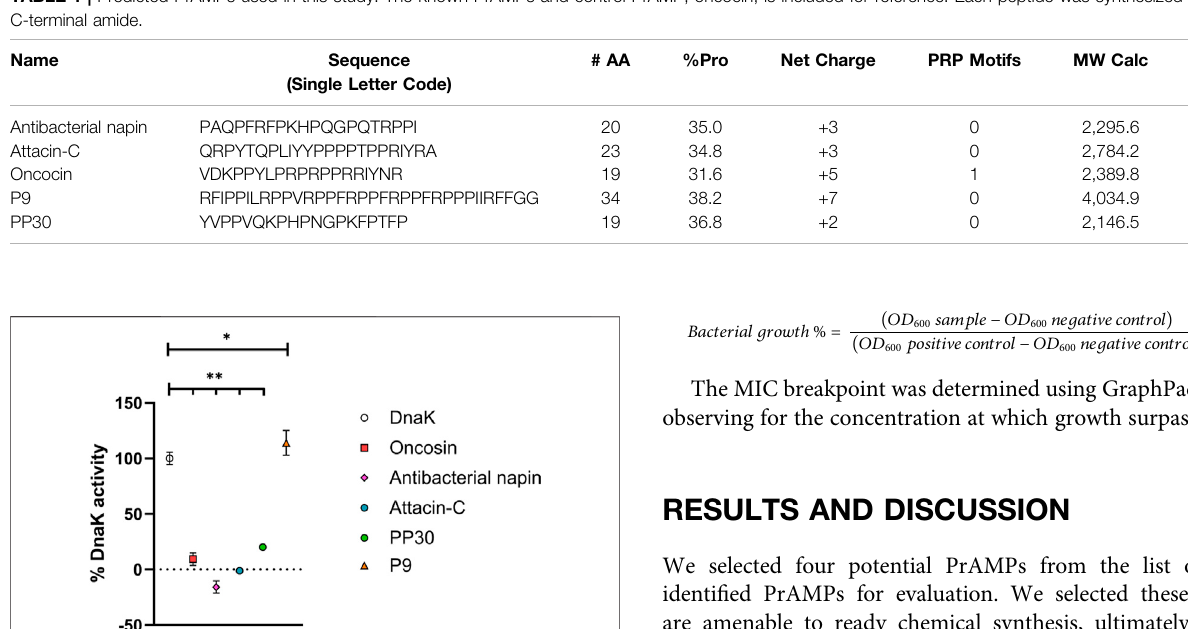
Frontiers in Chemistry |